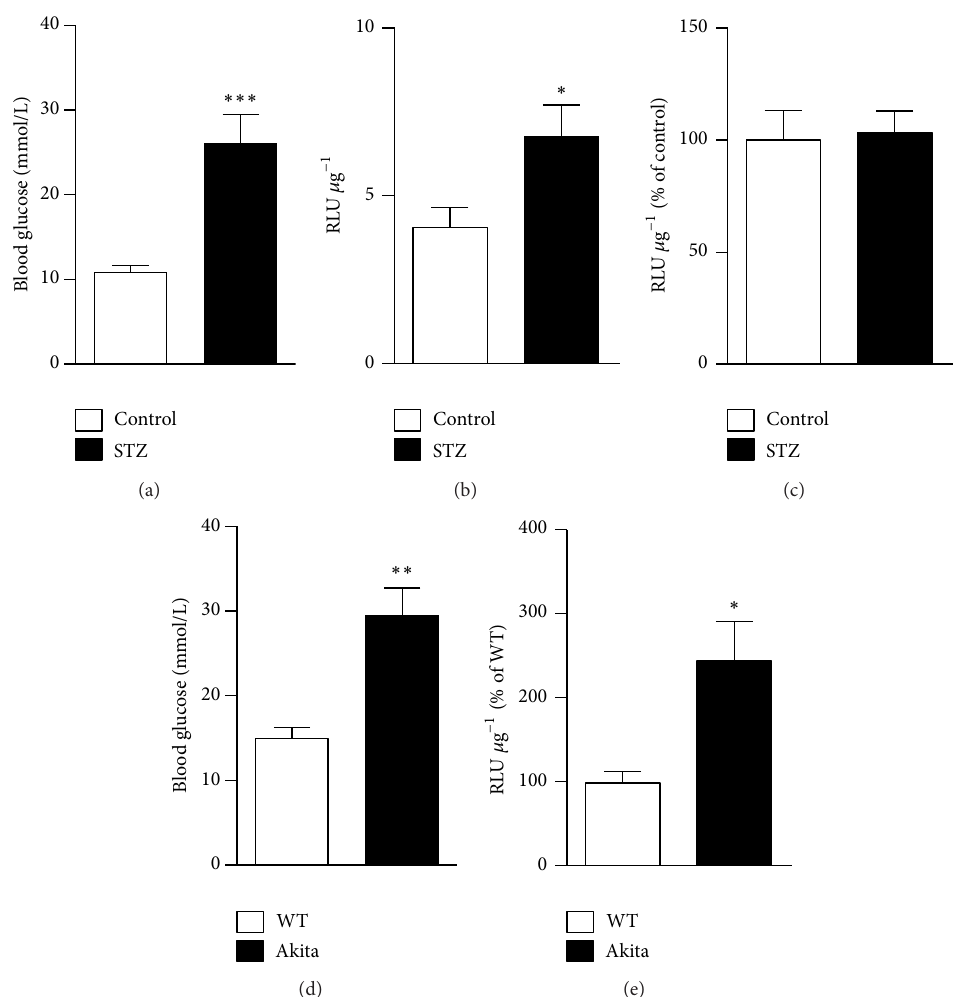
Figure 4: Chronic hyperglycemia increases NFAT-dependent transcriptional activity in retinal vessels from two different mouse models of diabetes. (a) Blood glucose levels in NFAT-luc mice, treated with STZ (60mg/kg; black bars) or vehicle (citrate buffer; white bars), measured 12 days after the first injection. (b) NFAT-dependent transcriptional activity (RLU 𝜇 g −1 ) in isolated retinal vessels ( 𝑁 = 6 - 7 mice/group) and (c) in whole retinas ( 𝑁 = 4 – 7 ) from the mice in (a). Data is expressed as percentage of activity in normoglycemic control mice. (d) Blood glucoselevelsinAkita/NFAT-lucmice(blackbars)andWT/NFAT-lucmice(whitebars)at6weeksofage.(e)NFAT-dependenttranscriptional activity (RLU 𝜇 g −1 ) in isolated retinal vessels from the same mice as in (d). Data is expressed as percentage of activity in WT control mice. 𝑁 = 11 – 15 mice/group. ∗ 𝑃 < 0.05 ; ∗∗ 𝑃 < 0.01 ; and ∗∗∗ 𝑃 < 0.001 versus corresponding normoglycemic control